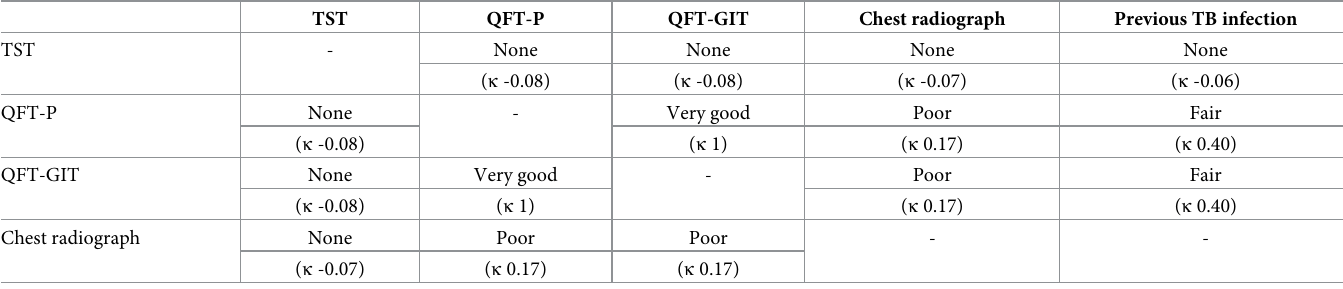
Table 2. Concordance between different screening methods for latent TB infection at baseline.